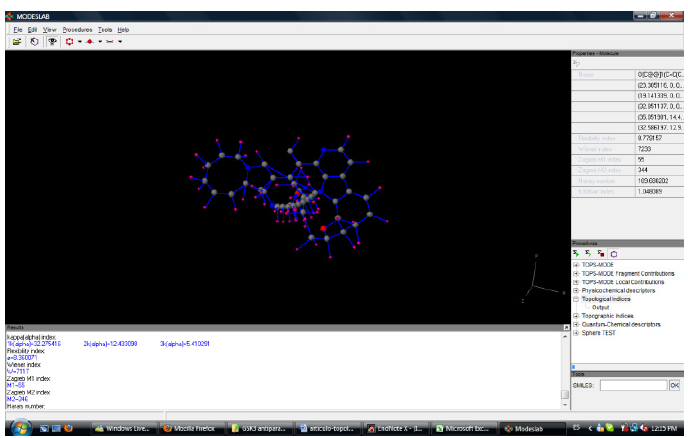
Figure 2. ModesLab